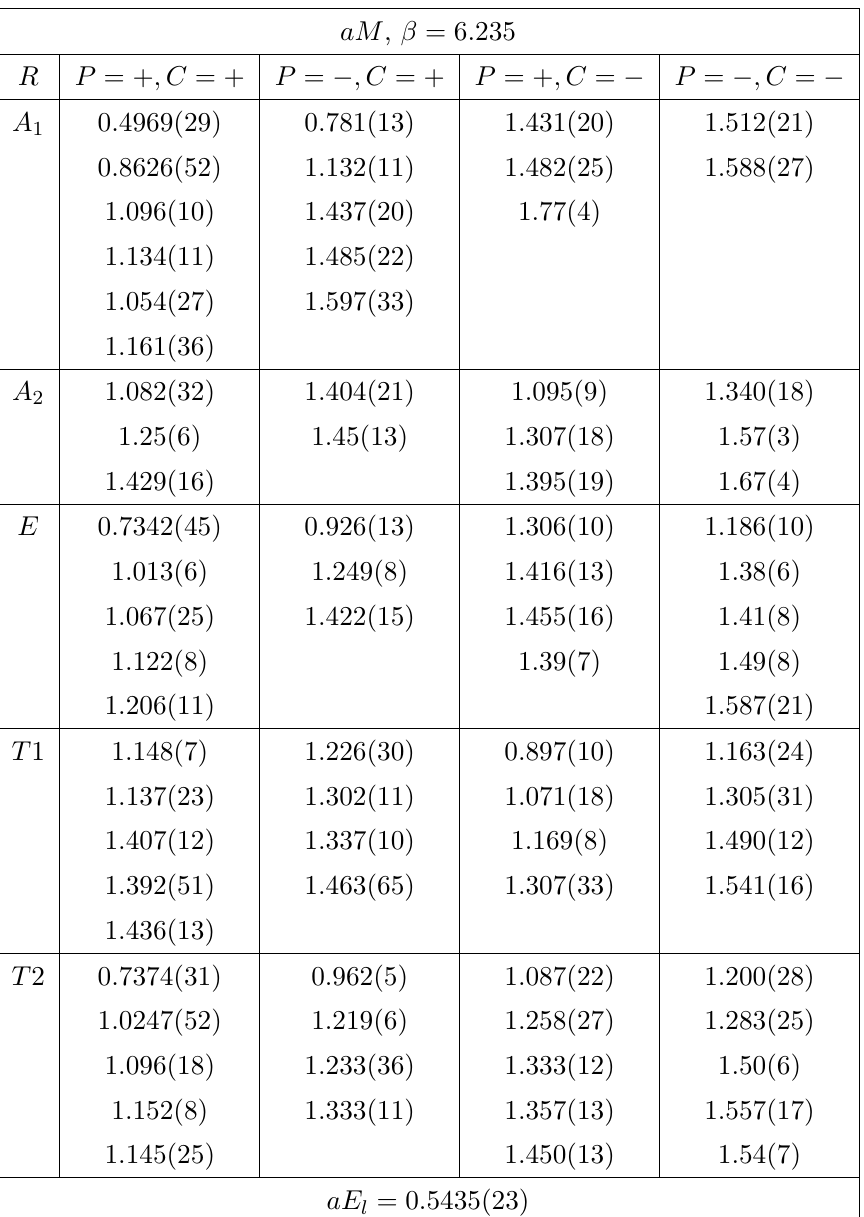
Table 11 . Glueball masses at β = 6 . 235 on a 26 4 lattice for all octahedral representations, R , and for both values of parity, P , and charge conjugation, C . Also the energy E l of a winding flux